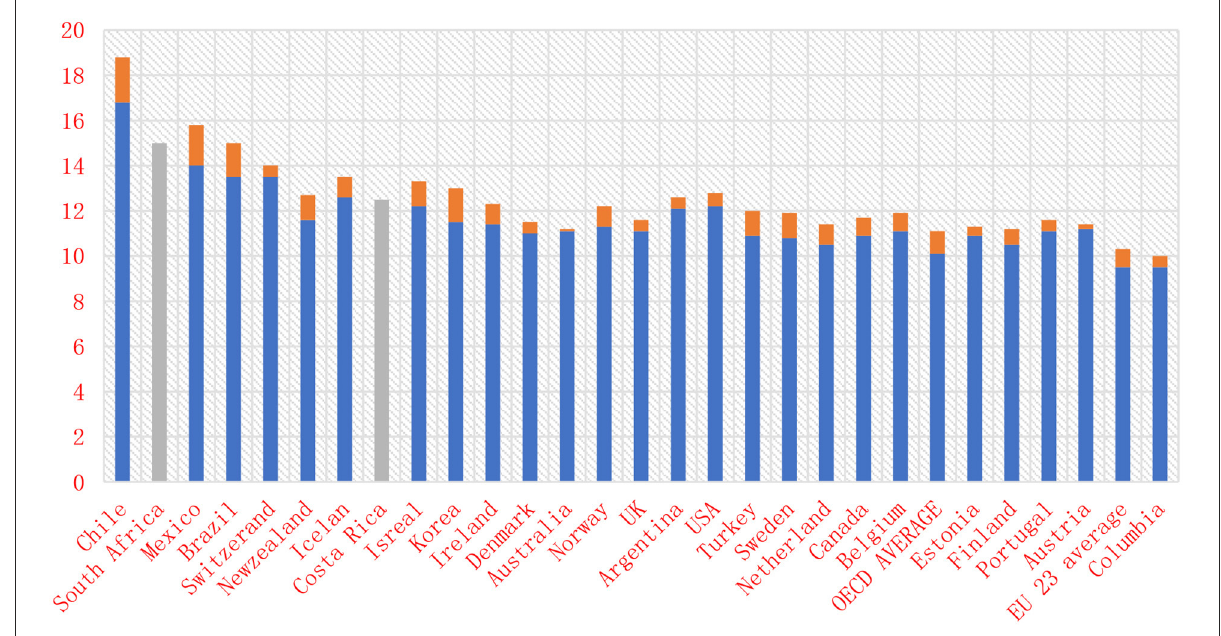
FIGURE1 Total public expenditure on education as a percentage of total government expenditure (2017).